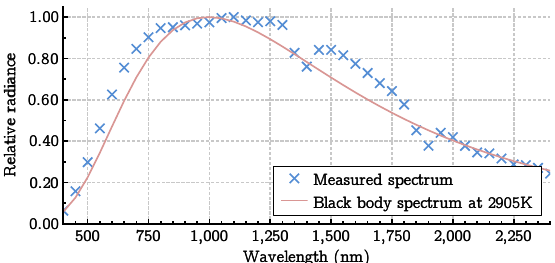
Figure 4. Spectrum of the 400-W halogen lamp used as a light source.